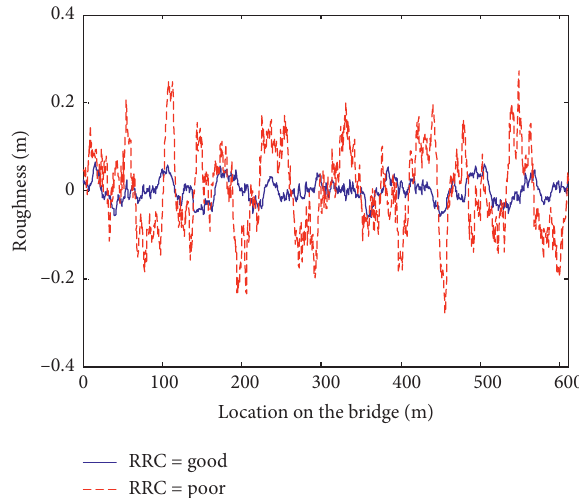
Figure 10: Samples of two types of road roughness conditions.